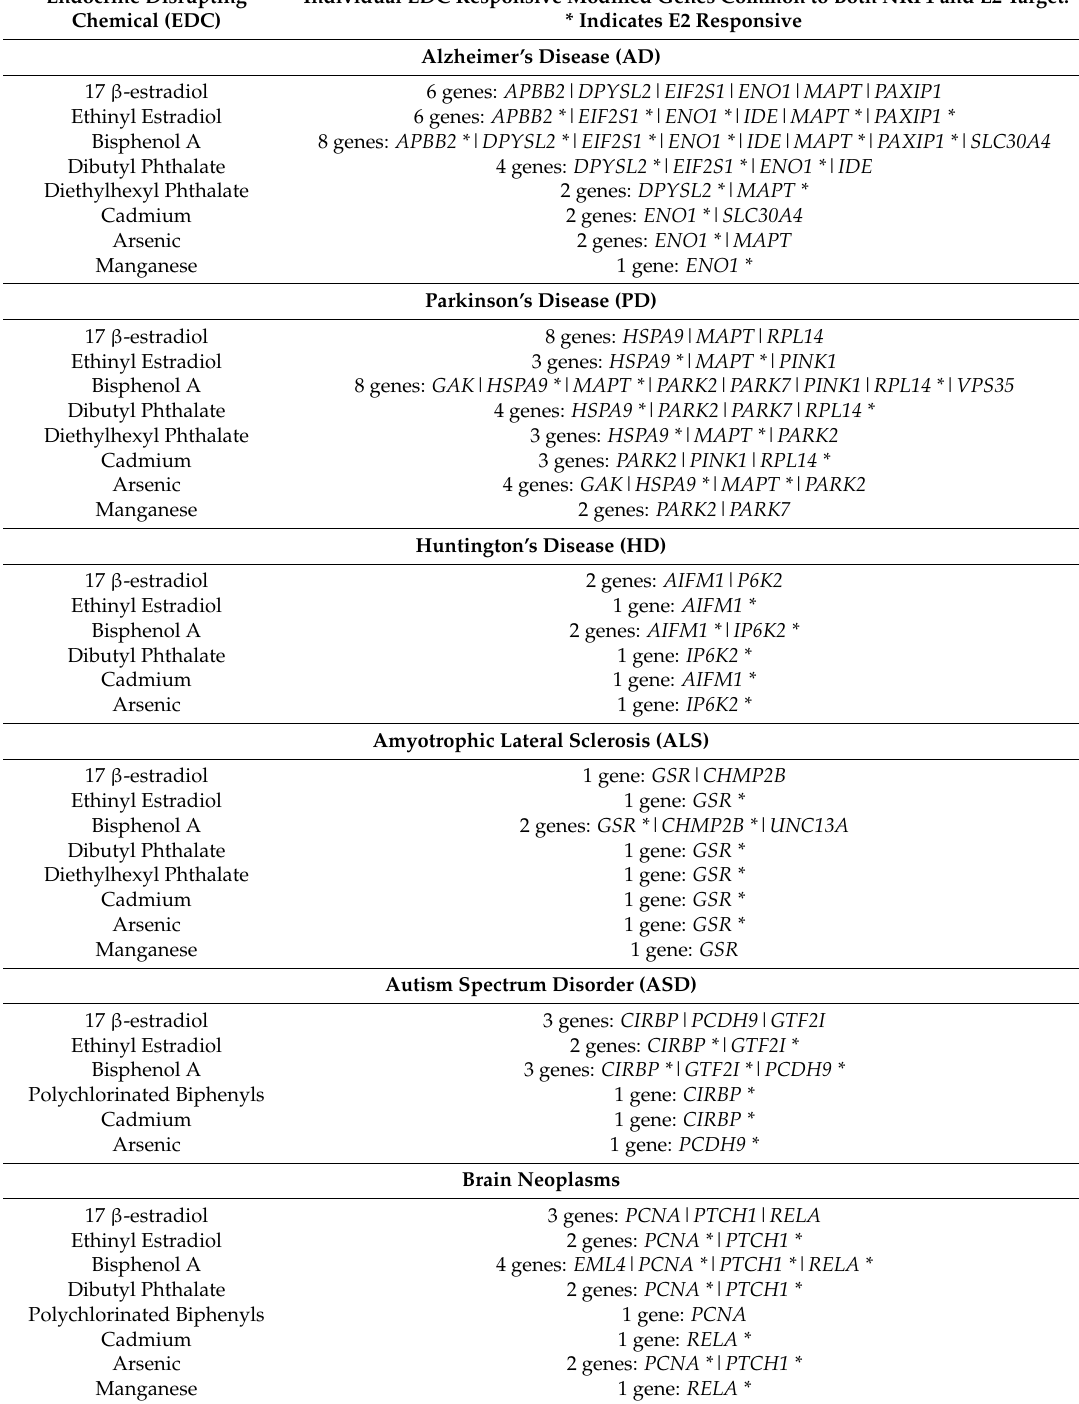
Table 5. Interaction of estrogenic endocrine disrupting chemicals modified genes with estrogen signaling and NRF1 network genes in the individual neurodegenerative